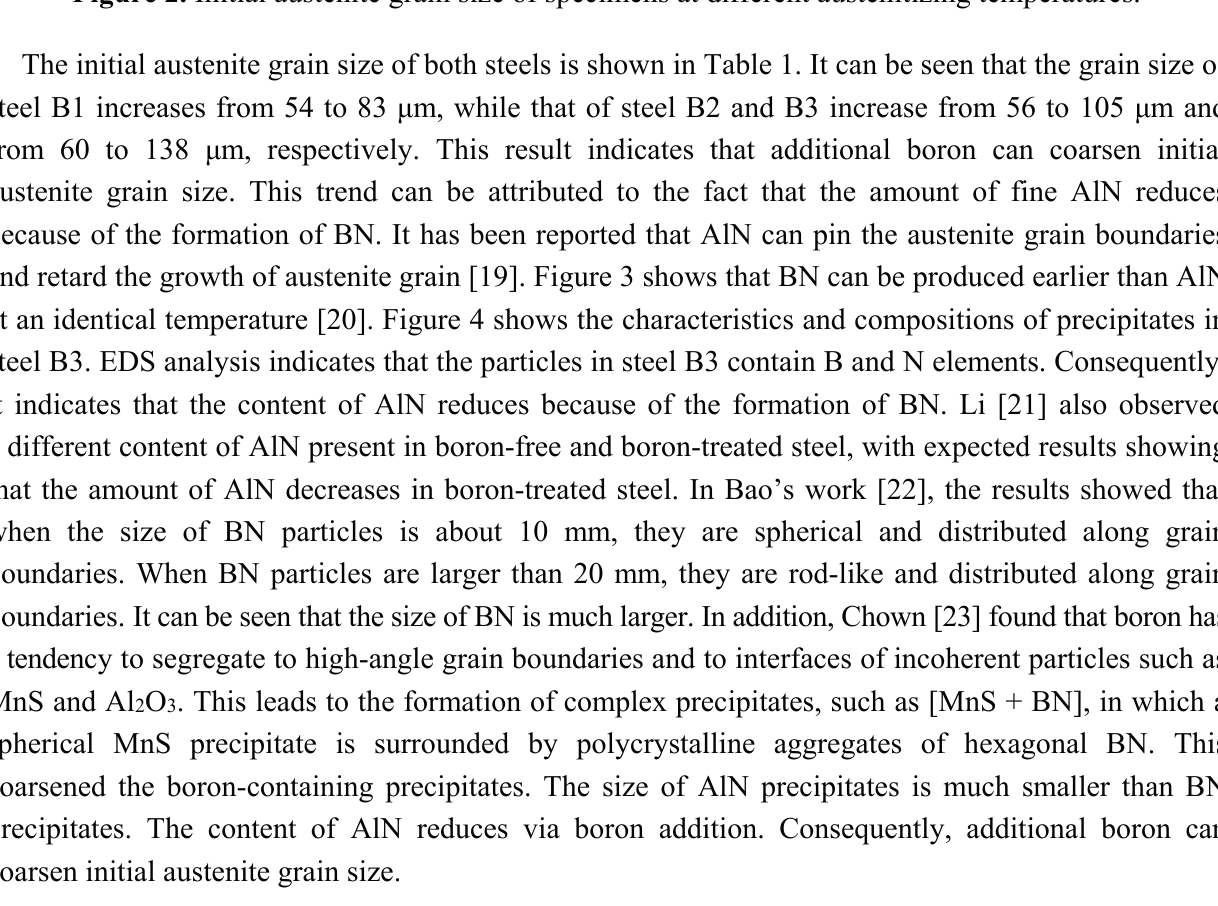
Figure 2. Initial austenite grain size of specimens at different austenitizing temperatures.